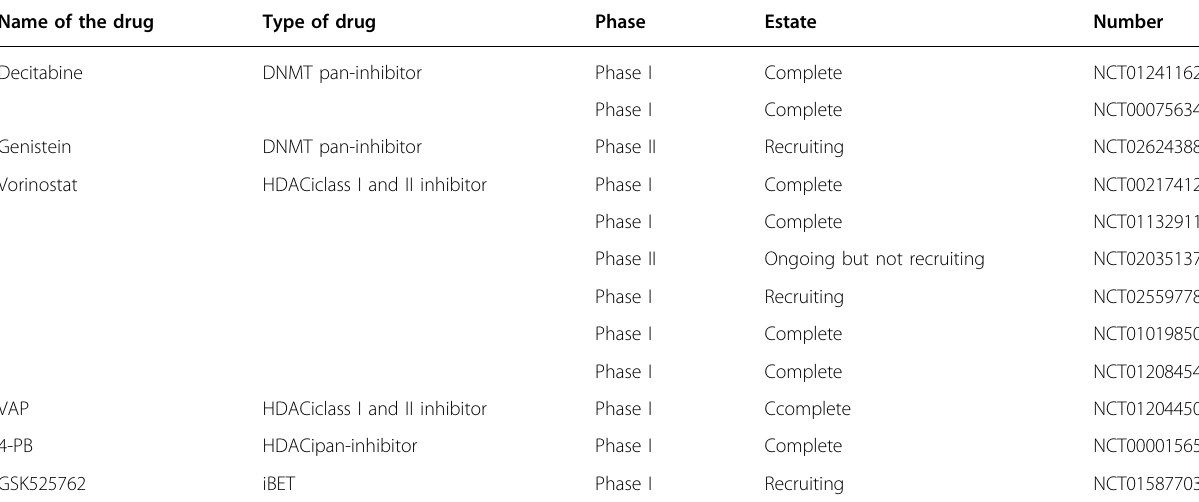
Table 2 Current epigenetic drugs clinical trials in Neuroblastoma Name of the drug Type of